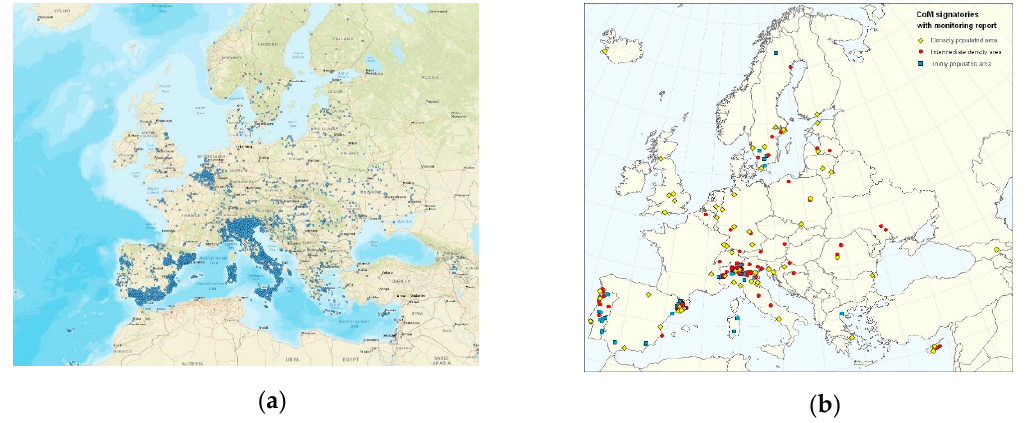
Figure 1. ( a ) Implementation of the Covenant of Mayors (CoM) by 2016 [42]; ( b ) CoM signatories with monitoring reports in the CoM Monitoring Emission Inventory dataset 2016 [42]. Source: Kona et al., 2016.